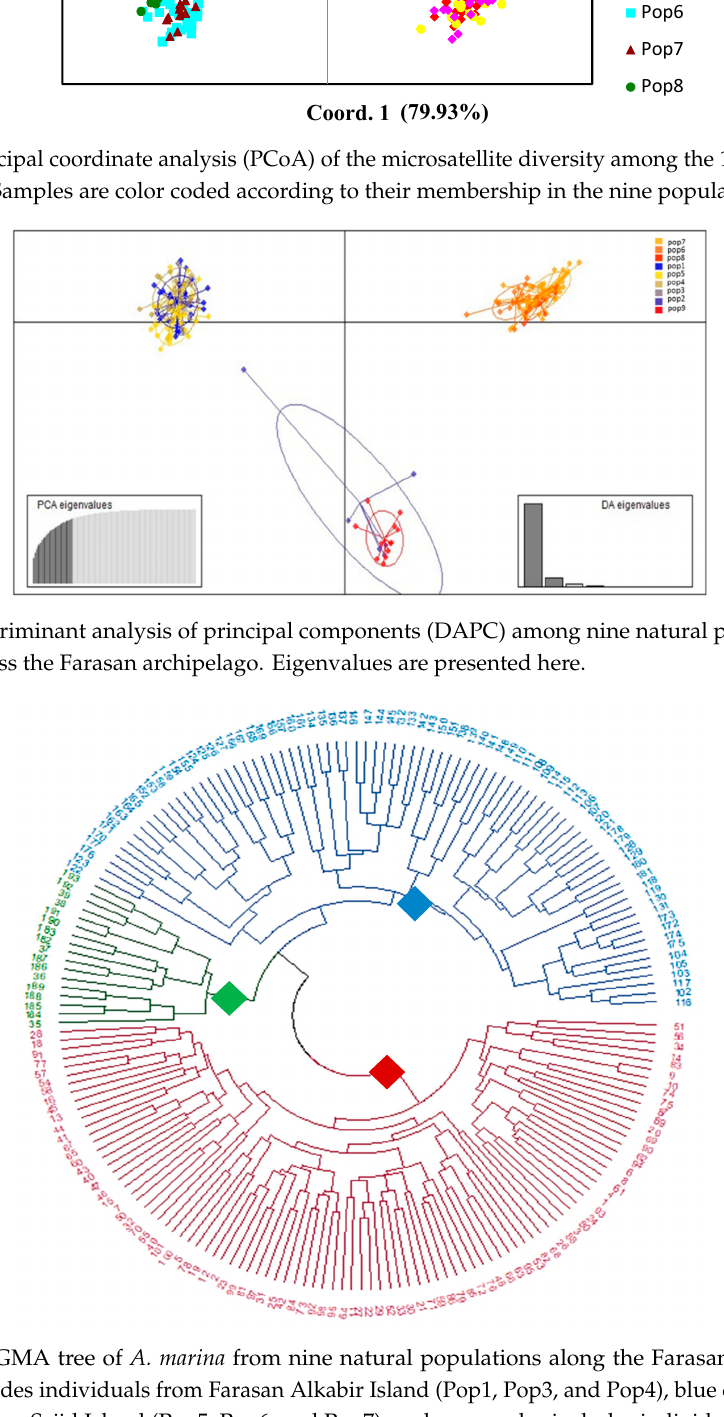
Island and Farasan Alkabir Island (Pop2 and individuals from Sajid Island (Pop5, Pop6, and Pop7), and green color includes individuals from Zifaf